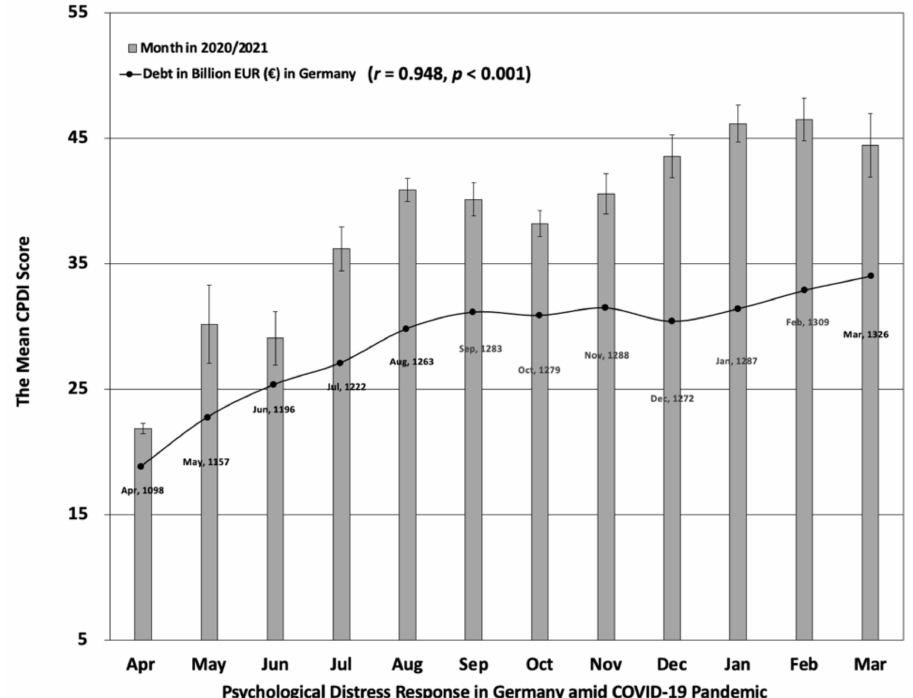
Figure 1. Psychological distress response and federal government debt (as an indicator of economic challenges) in Germany between April 2020 and March 2021. Error bars represent standard errors of the mean. Data of federal government debt in Germany retrieved from the Federal Republic of Germany–Finance Agency (https://www.deutsche-finanzagentur.de/en/finance-agency/public ations/, accessed on 7 June